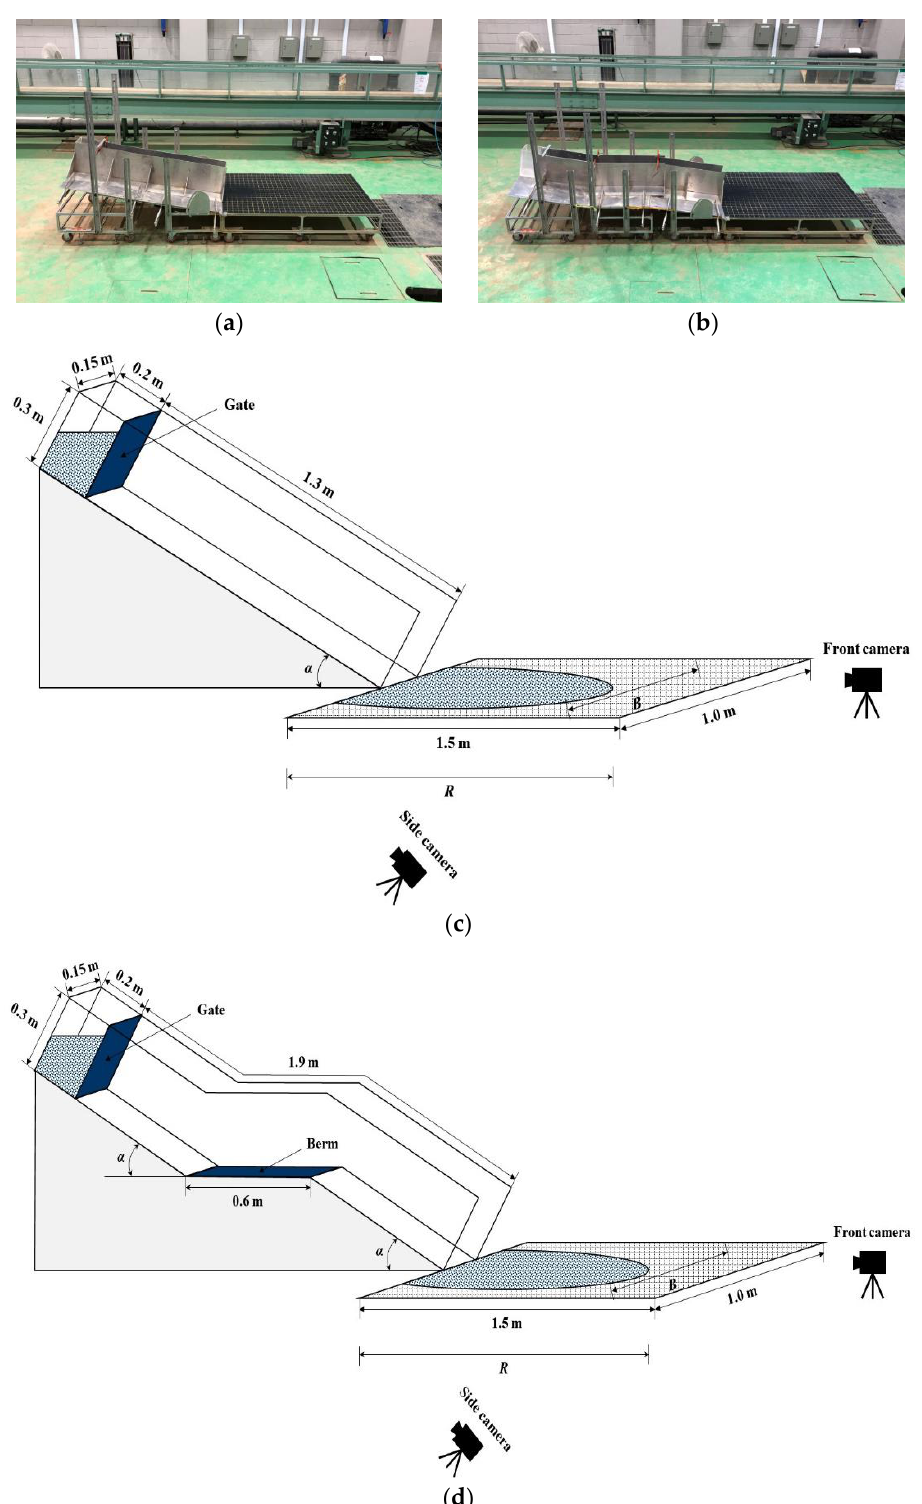
Figure 2. Experimental setups for laboratory tests: ( a ) Image of the straight channel test setup; ( b ) image of the single-berm channel test setup; ( c ) schematic diagram of the straight channel test; ( d ) schematic diagram of the single-berm channel test.